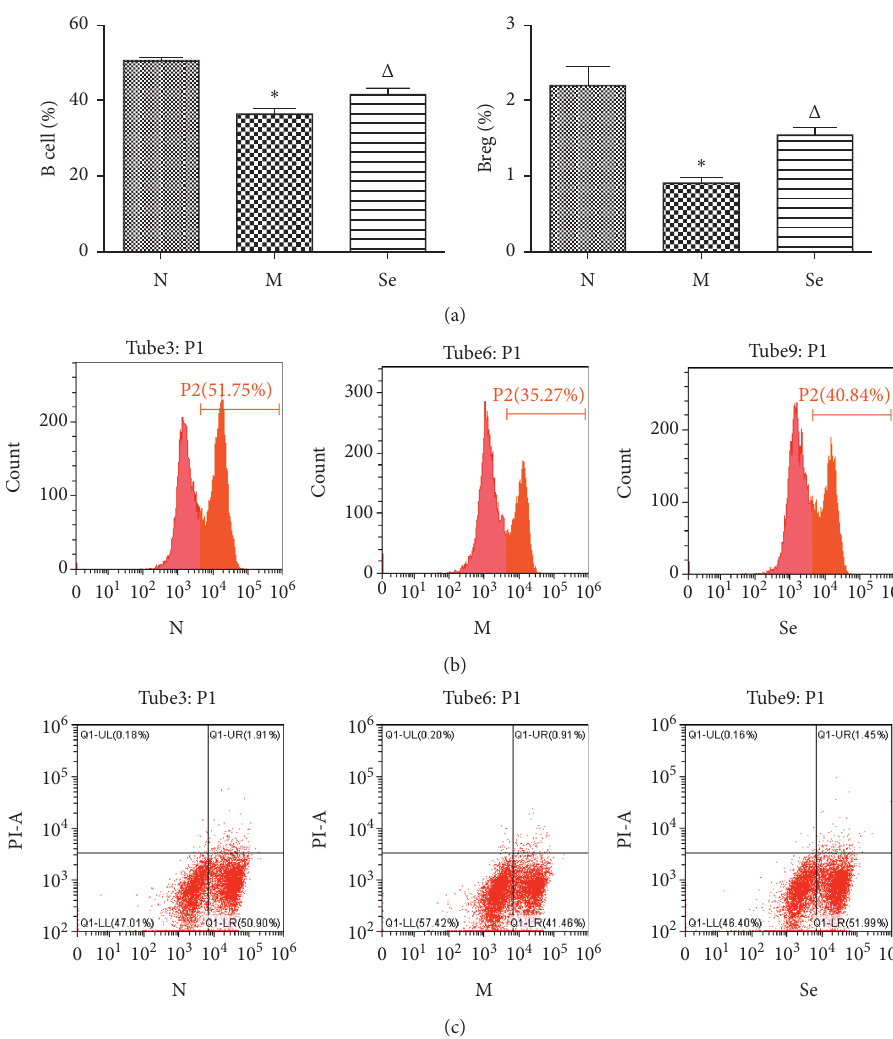
Figure 5: (a) B cell and Breg cell ratios in the spleen tested by flow cytometry. ∗ P < 0 . 05 compared to the N group. △ P < 0 . 05 compared to the M group. (b) Representative images of flow cytometry analysis of B cell. (c) Representative images of flow cytometry analysis of Breg